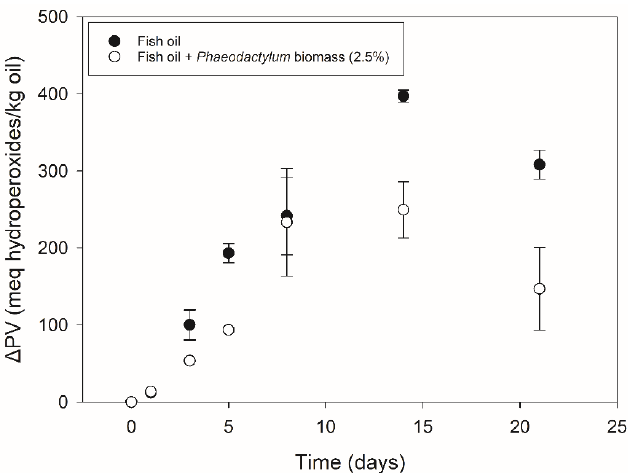
Figure 2. Primary oxidation of fish oil with (white symbols) and without (black symbols) 2.5% Phaeodactylum biomass addition during 21 days of storage at 37 °C. The peroxide values (mean ± sd, n = 2) are expressed as delta values, representing the relative increase or decrease compared to day zero. Information on statistical significance can be found in Supplementary Materials (Table S1).